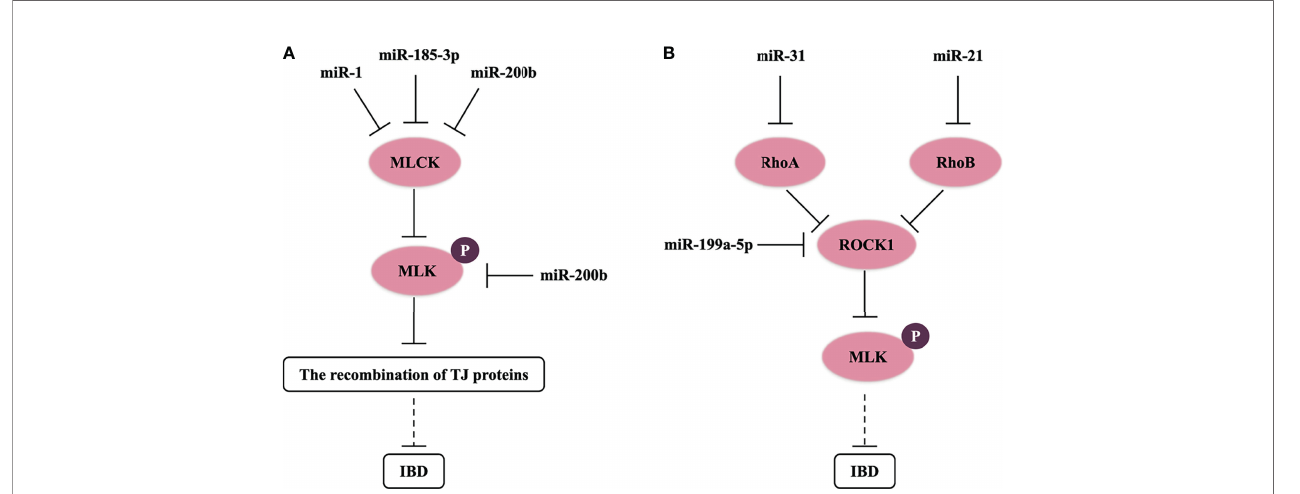
FIGURE 1 | miRNAs control MLCK/p-MLC and Rho/ROCK/p-MLC signaling pathway in IBD. (A) miR-1, miR-185-3p, and miR-200b target and inhibit MLCK or p- MLC levels to block the recombination of TJ proteins, and possibly reverse the impaired intestinal barrier function in IBD. (B) miR-21, miR-31, and miR-199a-5p respectively target and downregulate RhoB, RhoA, and ROCK1 levels, and possibly inhibit the progress of